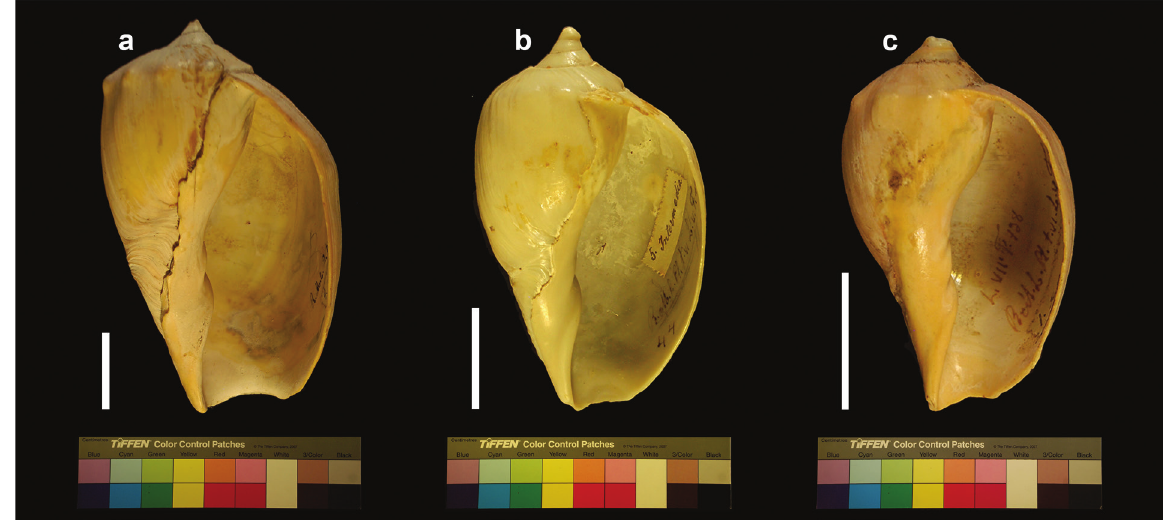
Figure 34. Voluta colocynthis intermedia , specimens figured by Lahille (1895). See references on Table 12. Scale bars: 3 cm.